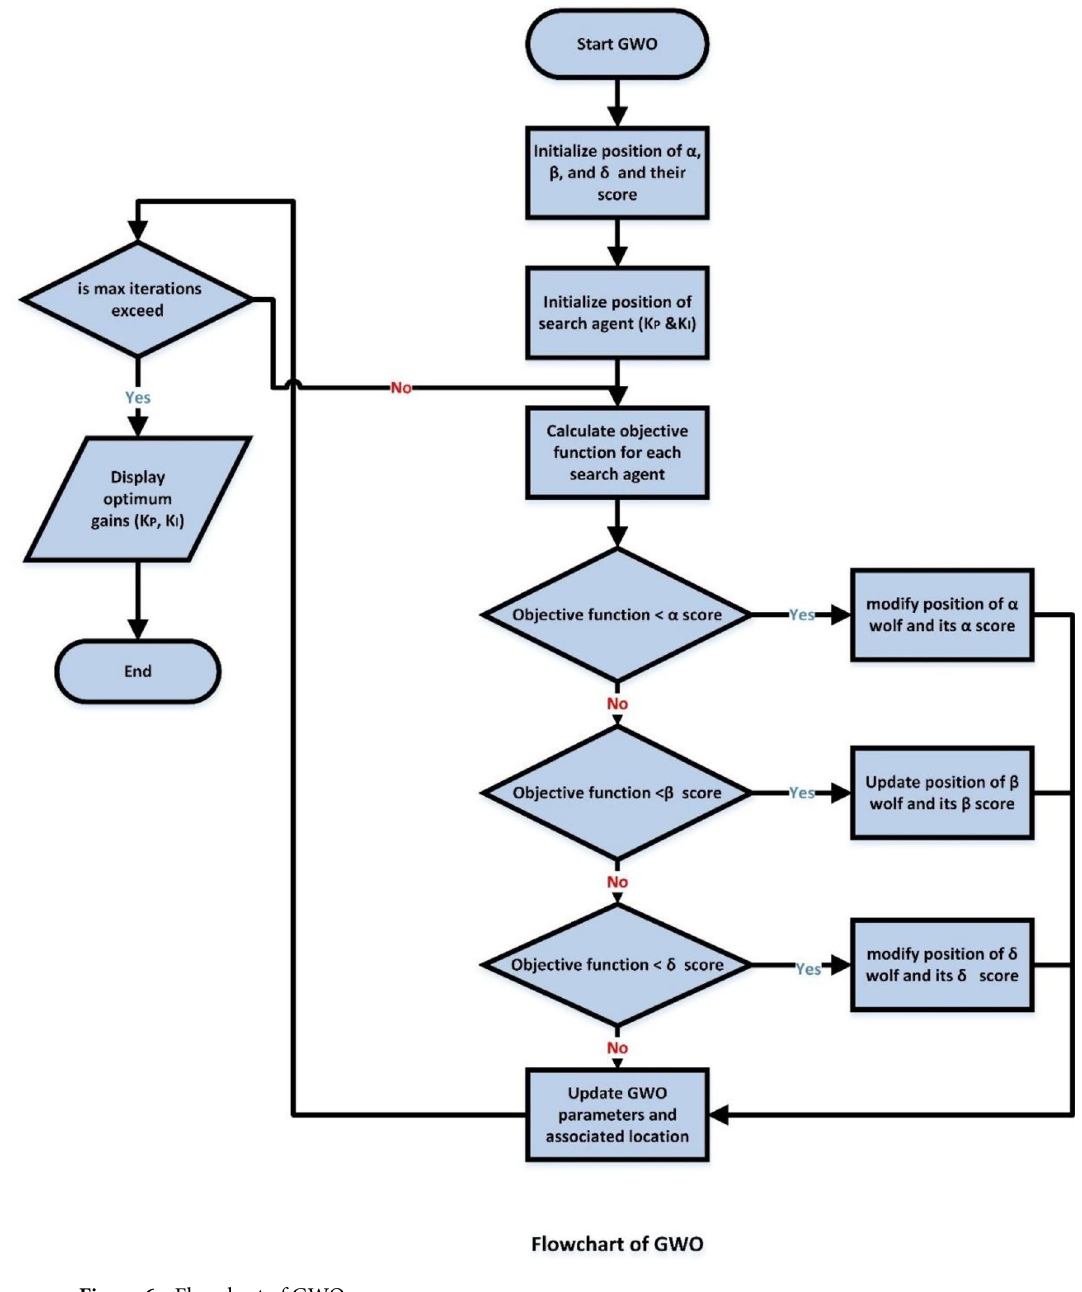
Figure 6. Flowchart of